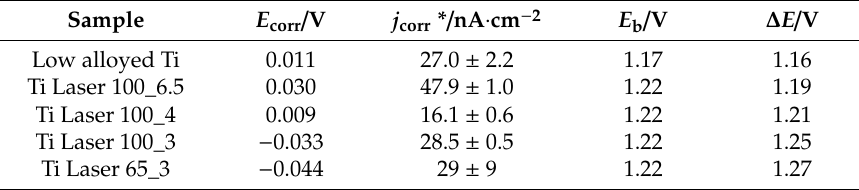
Table 3. Electrochemical parameters from potentiodynamic